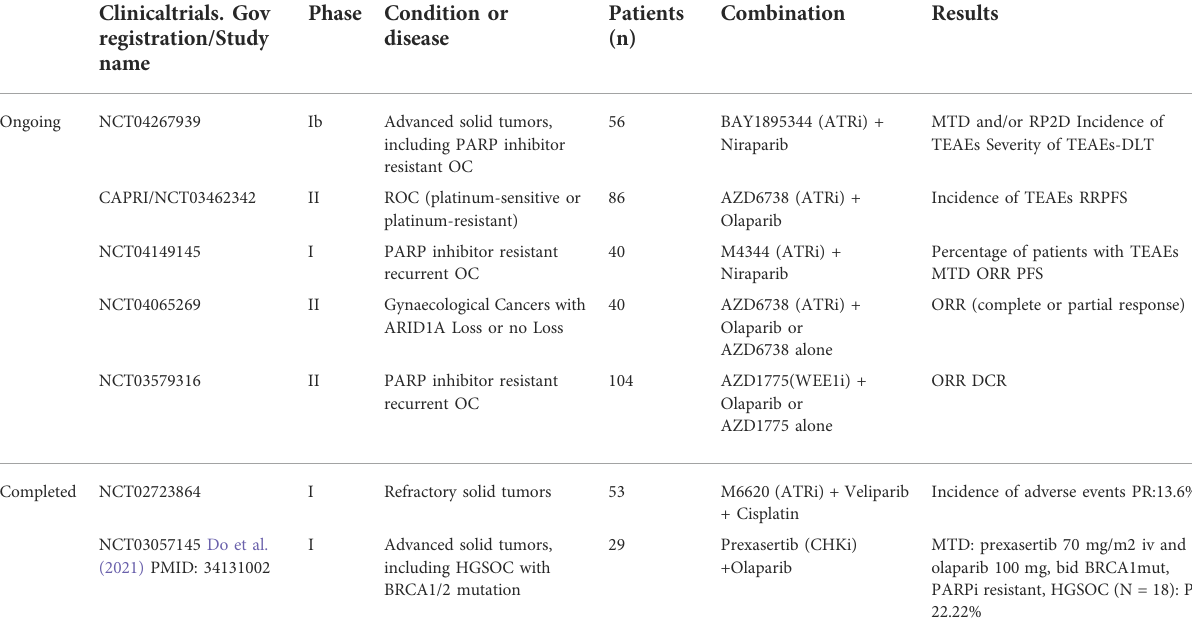
TABLE 1 Ongoing or completed clinical trials of ATR/CHK1/WEE1 pathway inhibitors combination with PARPi. Clinicaltrials. Gov